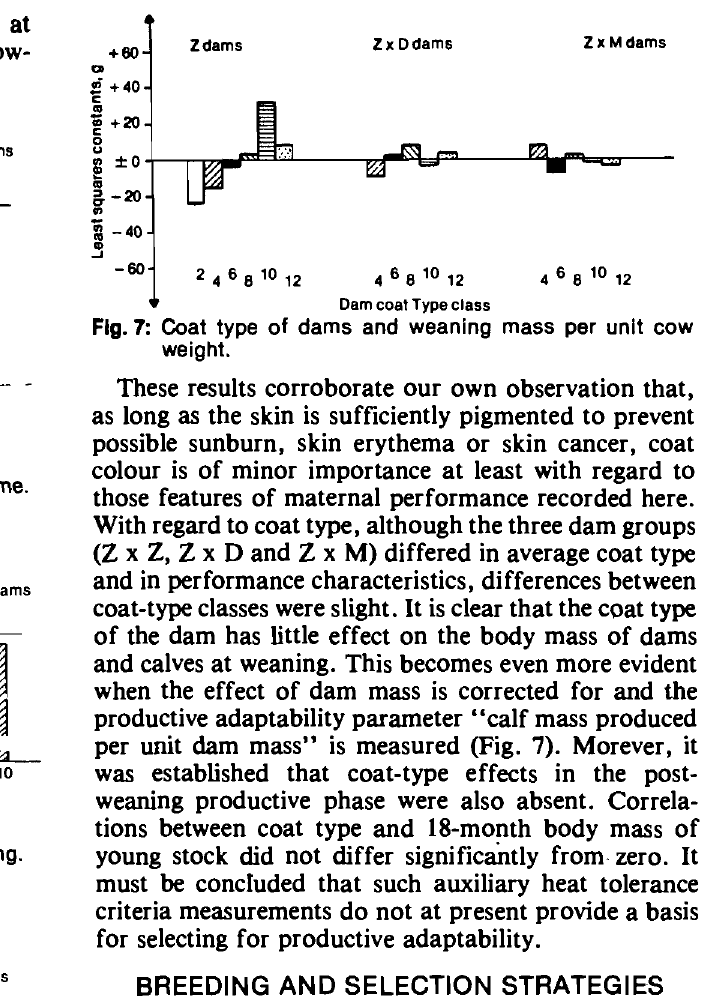
Dam coat Type class